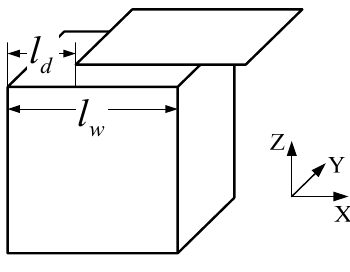
Figure 7. The final simplified model of the sensor.